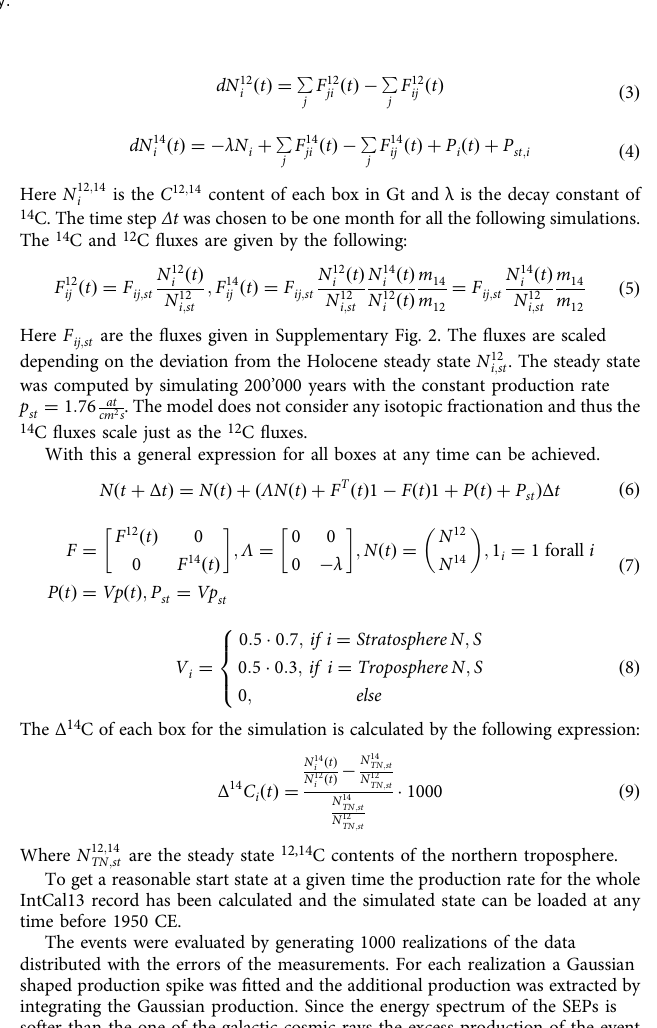
Fig. 4 Magnitude and occurrence of all known 14 C events over time. Shaded regions mark time periods where IntCal20 27 (purple) and our data (red) are based on annual or biennial resolution. Data points show the timing of all known (black) and newly identi fi ed (red) 14 C events and their normalized additional production with 1- σ errors. Event candidates are indicated in